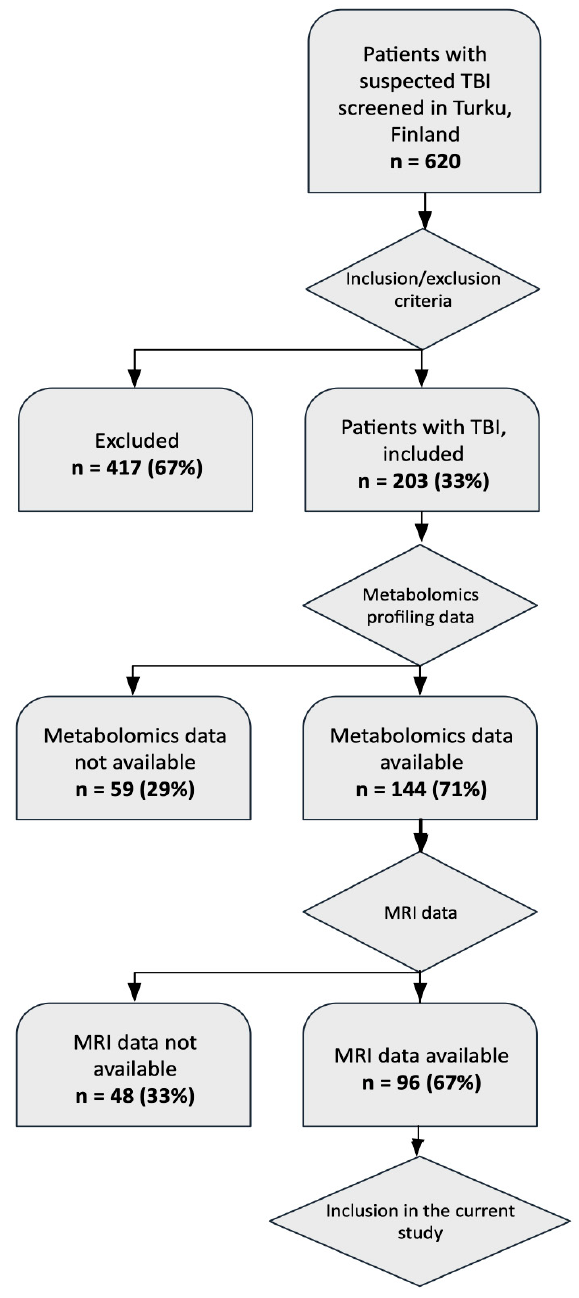
Figure 1. Flow chart showing how the patients were selected for the study. Partial correlations between metabolite clusters and ICs are shown in Figure 2. On that trigonal correlation matrix, we see, as variables, 15 ICs (numbered IC1-IC15), eight metabolite clusters (numbered V1-V8), age, pre-hospital GCS and GOS. Metabolite clusters 1, 2, 5, and 6 showed no correlation to the ICs, while clusters 3, 4, 7, and 8 correlated with at least one of the ICs. For the four clusters that showed correlation with the sMRI data, correlations with specific areas of the brain were calculated and projected onto a manually-segmented reference brain, that was used to generate a probabilistic brain atlas from the OASIS database [24]. Strong correlations of these four metabolite clusters with distinct areas of the brain were observed (Figure 3). The top brain regions that correlated positively with Cluster 3 were the right anterior cingulate gyrus, right anterior insula, right middle frontal gyrus, left planum polare, and the right supramarginal gyrus. The top brain regions